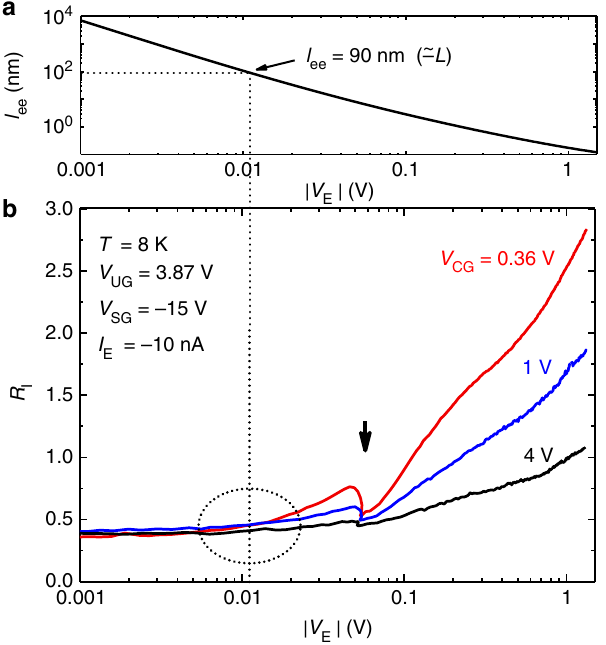
Fig. 3 Calculated scattering length l ee and measured R I as a function of | V E |. a Calculated scattering length l ee . The vertical dotted line indicates the | V E | value ( = 11 mV) that gives l ee = 90 nm ( ≃ L ). b R I as a function of | V E | using V CG as a parameter. The dotted circle shows the broad threshold at which the R I starts to increase. The arrow indicates the accidental drop of R